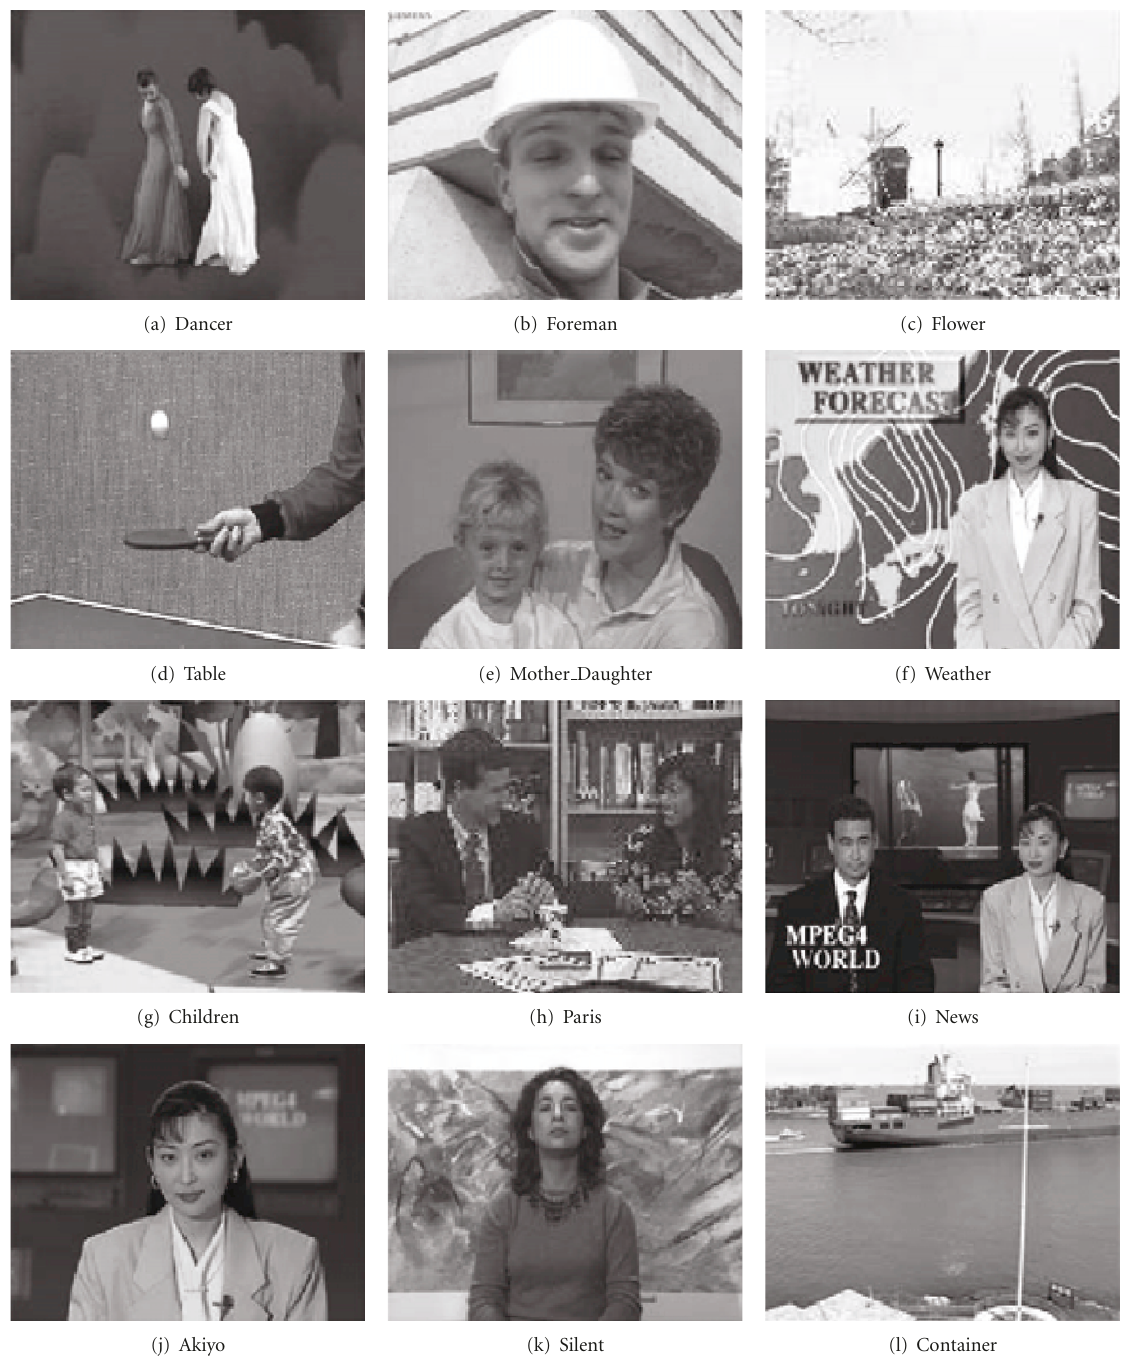
Figure 6: Test clips: (a) Dancer, (b) Foreman, (c) Flower, (d) Table, (e) Mother Daughter, (M D) (f) Weather, (g) Children, (h) Paris, (i) News, (j) Akiyo, (k), and Silent (l)